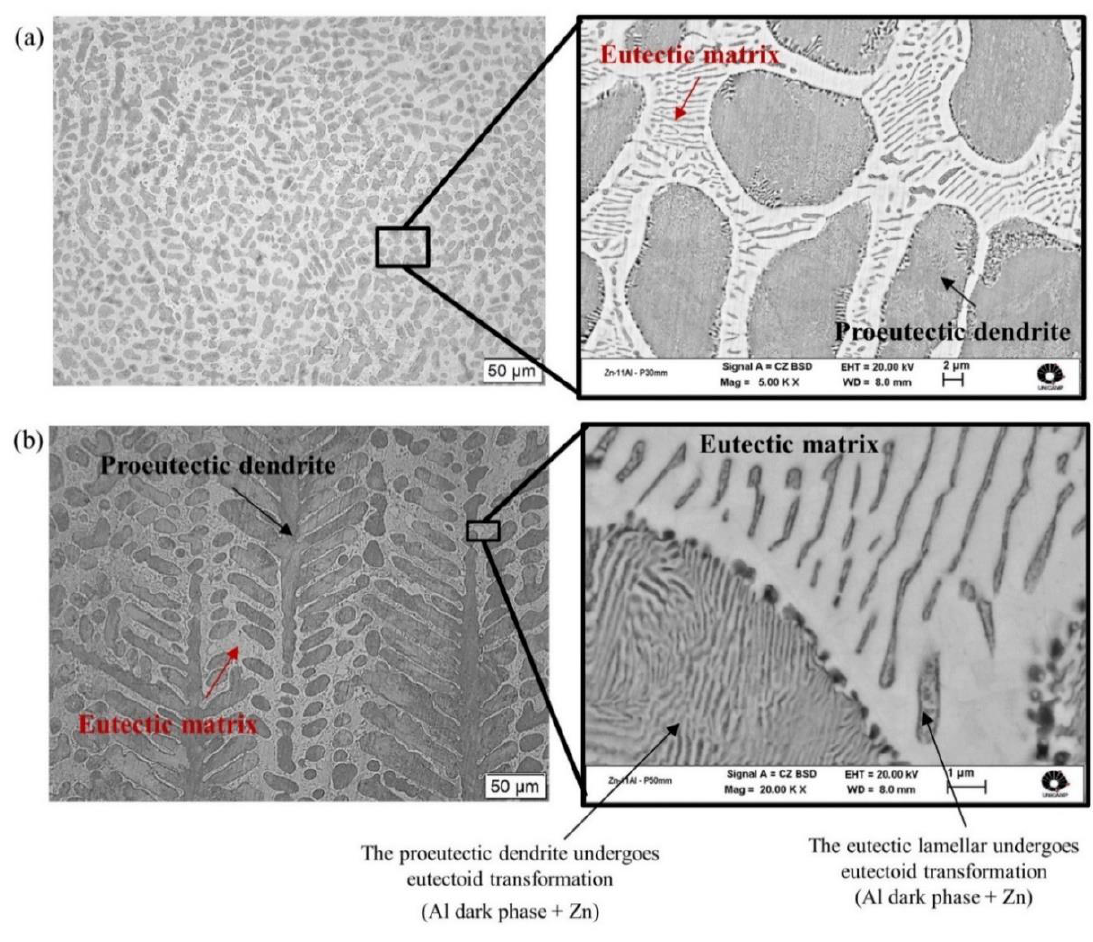
Figure 11. Typical microstructure of the Zn – 11wt.% Al alloy highlighting a eutectic lamella in a ( a ) transverse and ( b ) longitudinal sections of the DS casting. The samples were extracted at 30 mm and 50 mm from the cooled bottom of the casting, respectively.